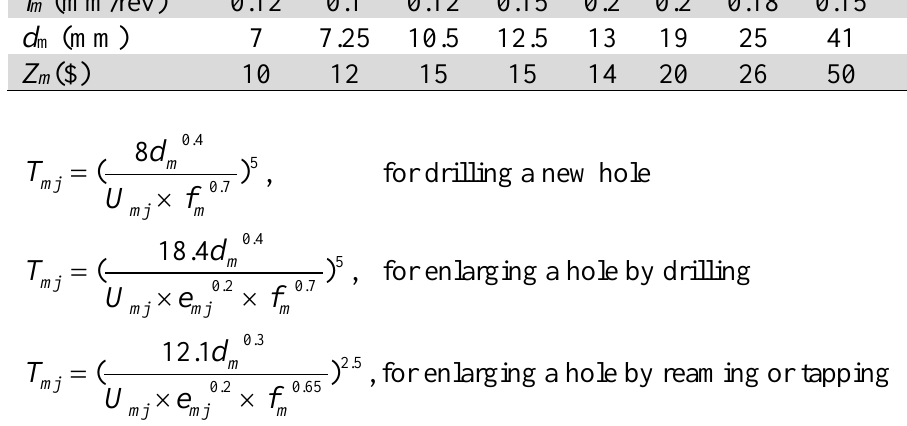
Data of tool diameter, cost, and specified feed rate considered for an application example. Tool type m